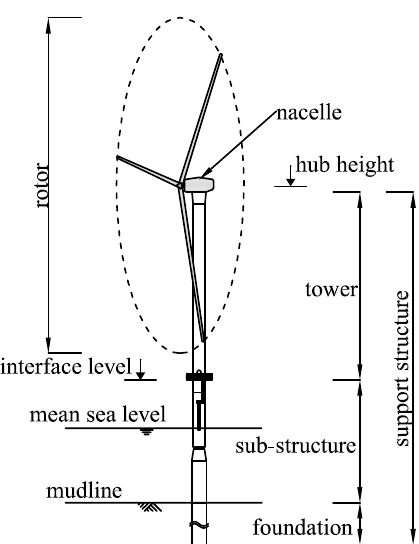
Figure 1. Schematic representation of a three-bladed monopile-based offshore wind turbines with the definitions according to DNVGL-ST-0126 [13].